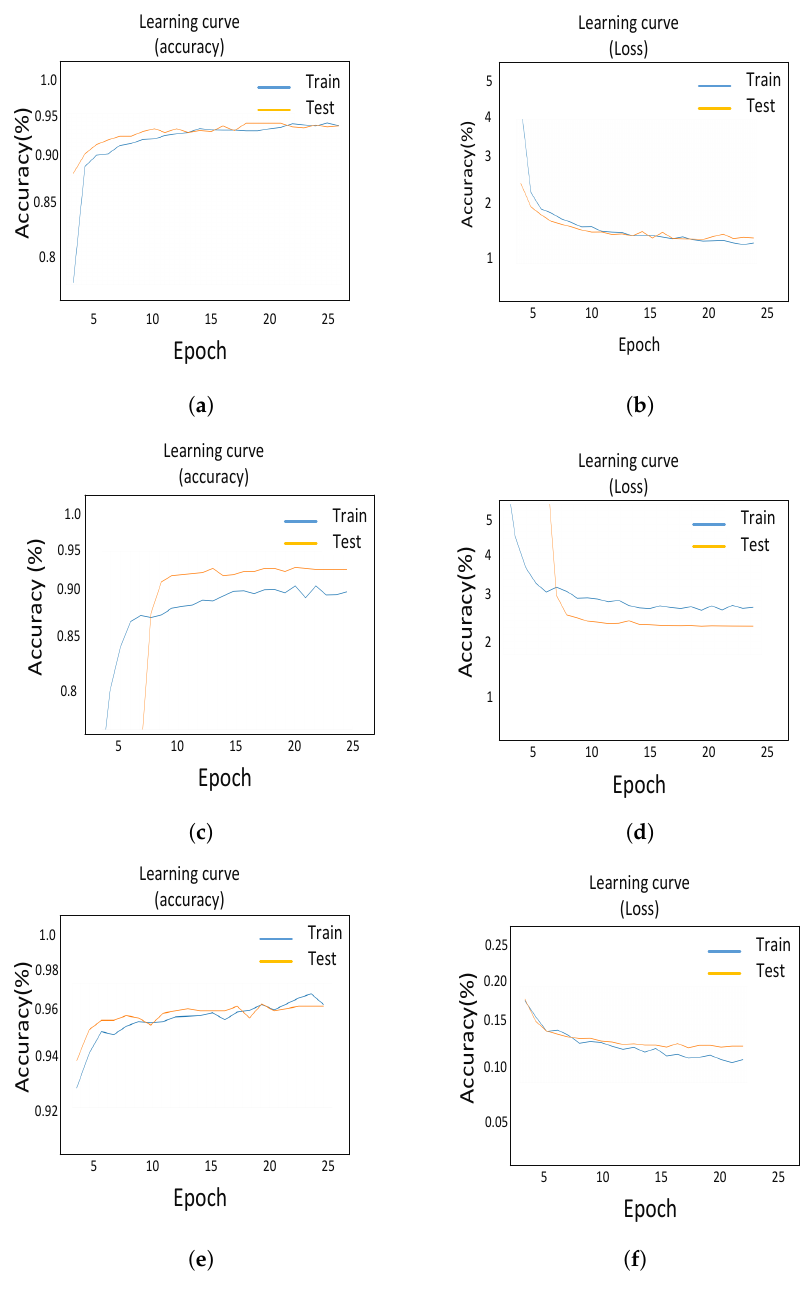
Figure 16. Confusion matrices for CNN, transfer learning and the fine tuning-based proposed model. ( a ) Accuracy curve for CNN model. ( b ) Loss curve for CNN model. ( c ) Accuracy curve for transfer learning model. ( d ) Loss curve for transfer learning model. ( e ) Accuracy curve for fine tuning model. ( f ) Loss curve for fine tuning